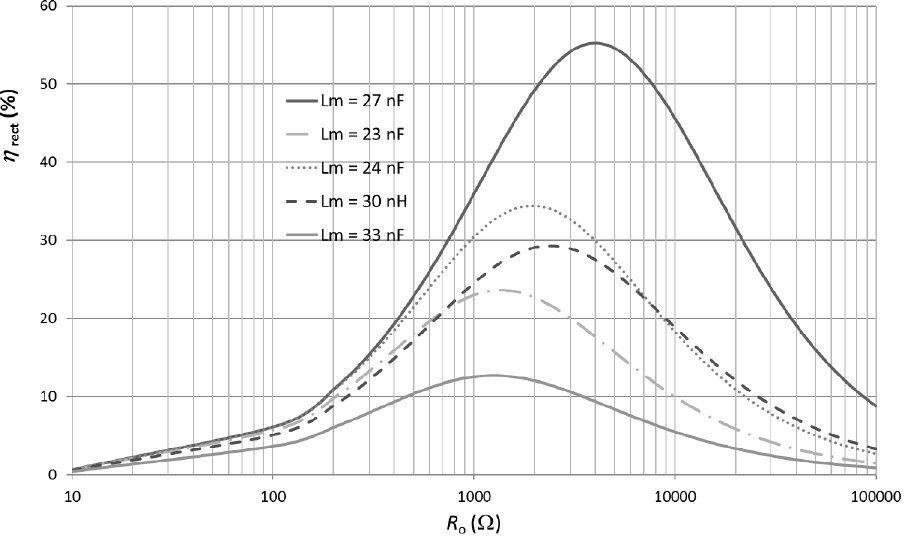
Figure 7. Simulation results of η rect versus R o for several values of L m at C m = 0.5 pF ( G t = 3.7) and P av = − 10 dBm.